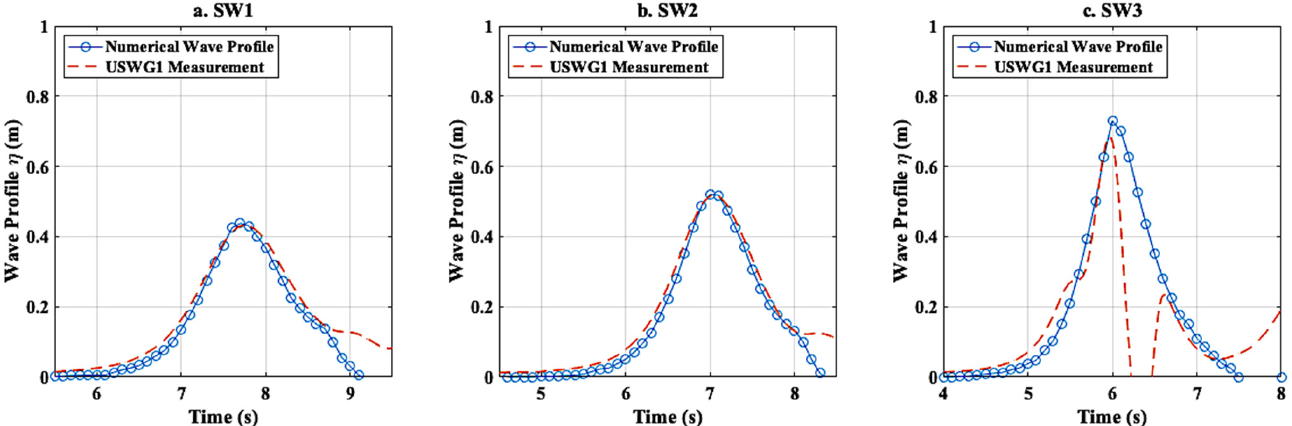
Figure 2. Comparison of wave profile at USWG1 between experimental measurements (source: Istrati [19]) and numerical simulations.